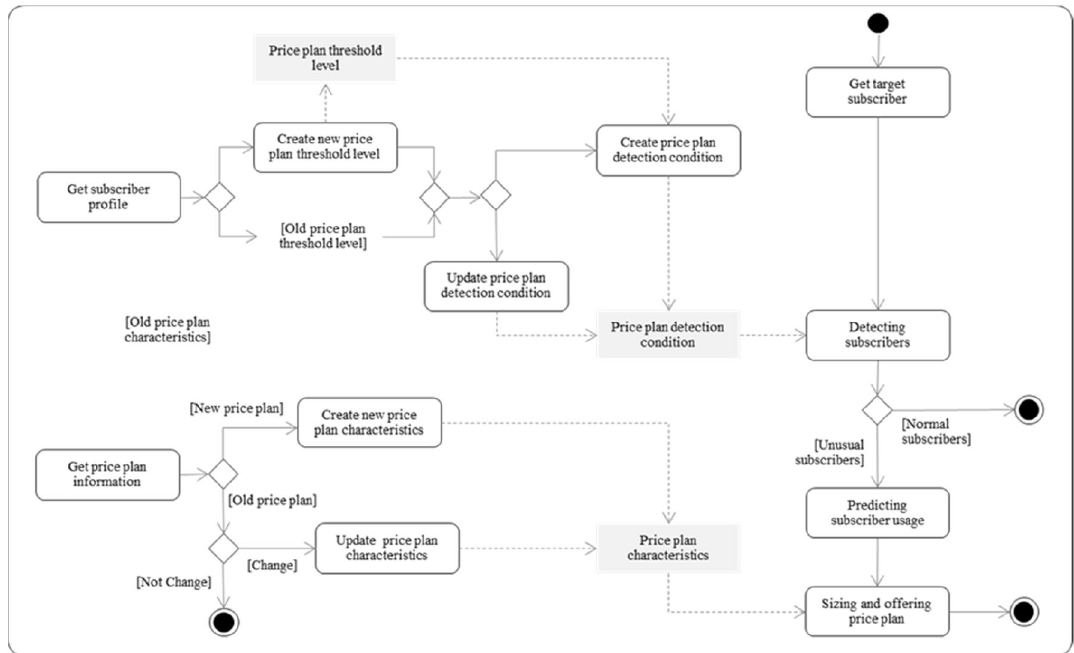
Fig. 3. Activity diagram of Innovative price plan and monitoring and advisory